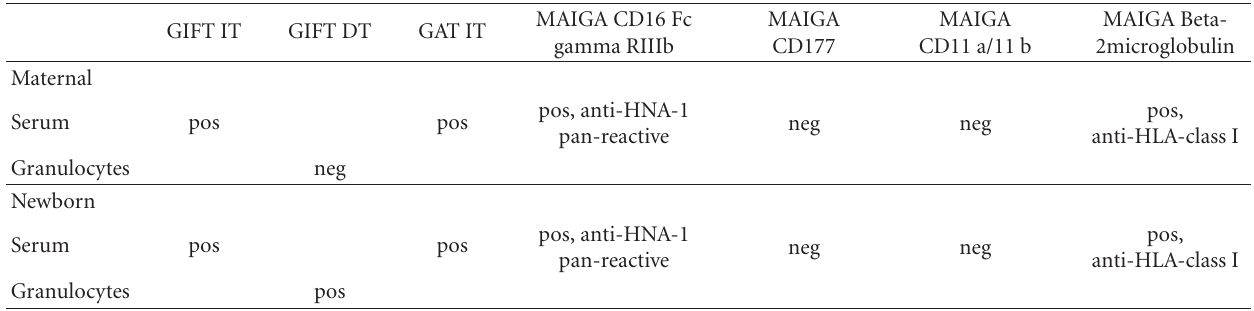
Table 1: Results of serologic